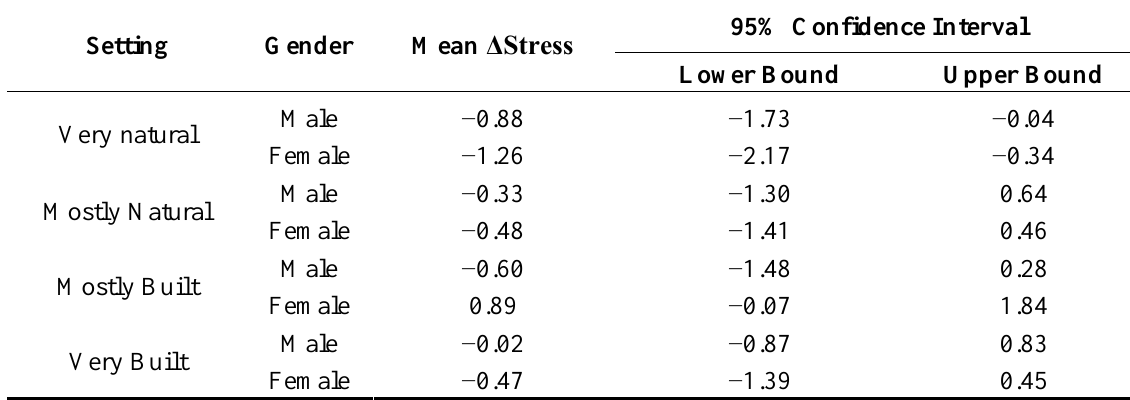
Table 1. Setting × Gender adjusted means for